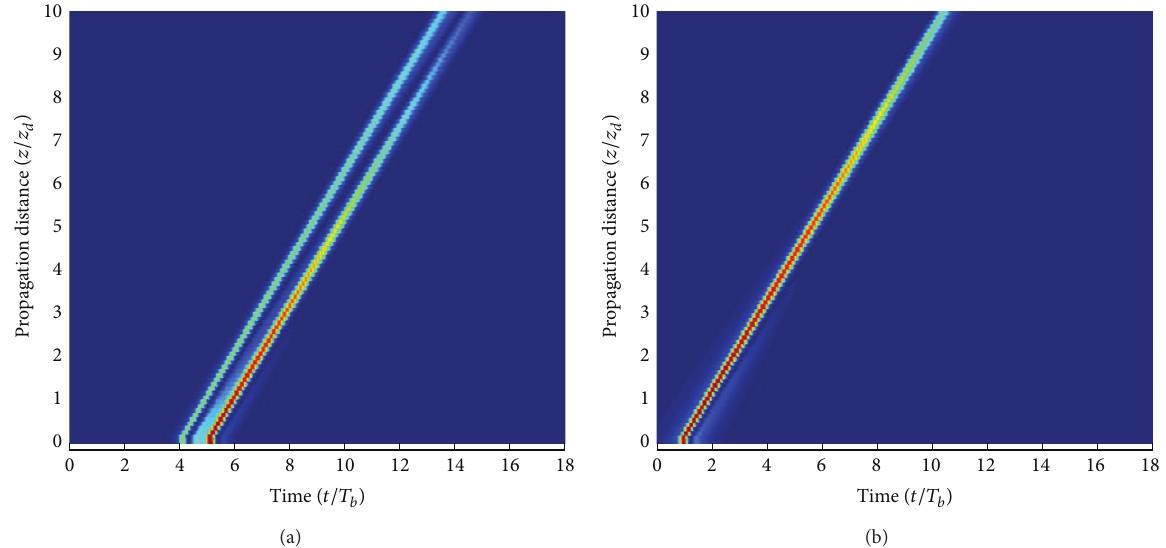
Figure 7: Spatial evolution of the normalized electric field intensity distribution through a dielectric slab of soil at 𝑓 0 = 1.5 GHz, IMR model: (a) rectangular pulse with 𝑇 𝑏 = 10/𝑓 0 and (b) FDG pulse with 𝑇 𝑏 = 1/𝑓 0 . Amplitude levels range in the interval [0,1]